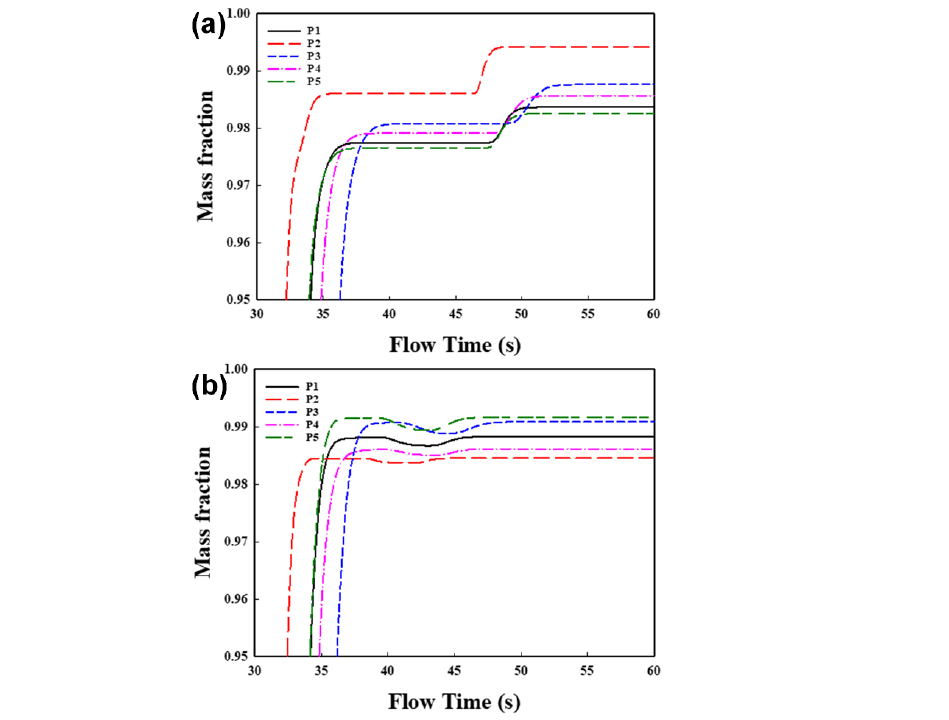
Figure 7. Simulated slurry mass fraction of five monitoring points with time on the ( a ) R0 pad, and ( b ) R32 pad in the 100 mm wafer polisher.